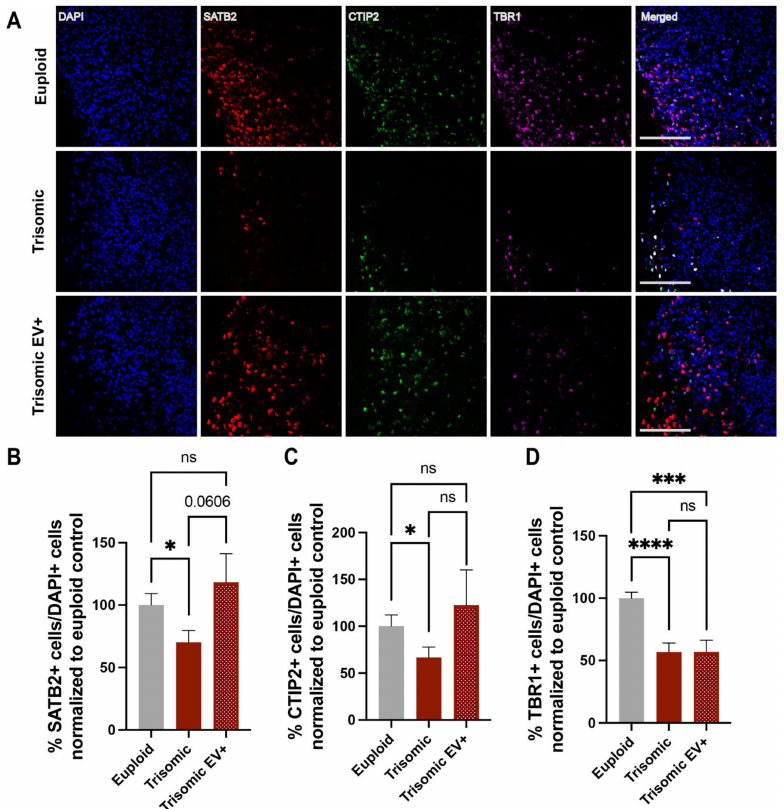
Figure 3. The effect of EV treatment on neuronal populations in trisomic CS. ( A ) Single and merged channels of confocal images showing DAPI staining with IHC labeling of TBR1 (magenta), CTIP2 (green) and SATB2 (red) in euploid and trisomic untreated and EV-treated CS generated from isogenic cell lines. Scale bar = 100 µ m. ( B – D ) Bar graphs showing quantification of percentages of SATB2+, CTIP2+, and TBR1+ cells in euploid CS and trisomic untreated and EV-treated CS, quantified as the ratio of the numbers of CTIP2+, SATB2+, and TBR1+ to the number of all cells marked with DAPI and normalized to the euploid control that was calculated as 100% for each independent experiment. Cells were counted using the ACEq counting app; euploid n = 18; trisomic n = 22; trisomic EV+ n = 22 CS per group. These graphs reflect the results obtained from data collected from three independent experiments. Statistical analysis performed via unpaired t -test with Welch’s correction comparing all three groups to each other. Results are shown as mean ± SE. * p < 0.05, *** p < 0.001, **** p < 0.0001, ns =